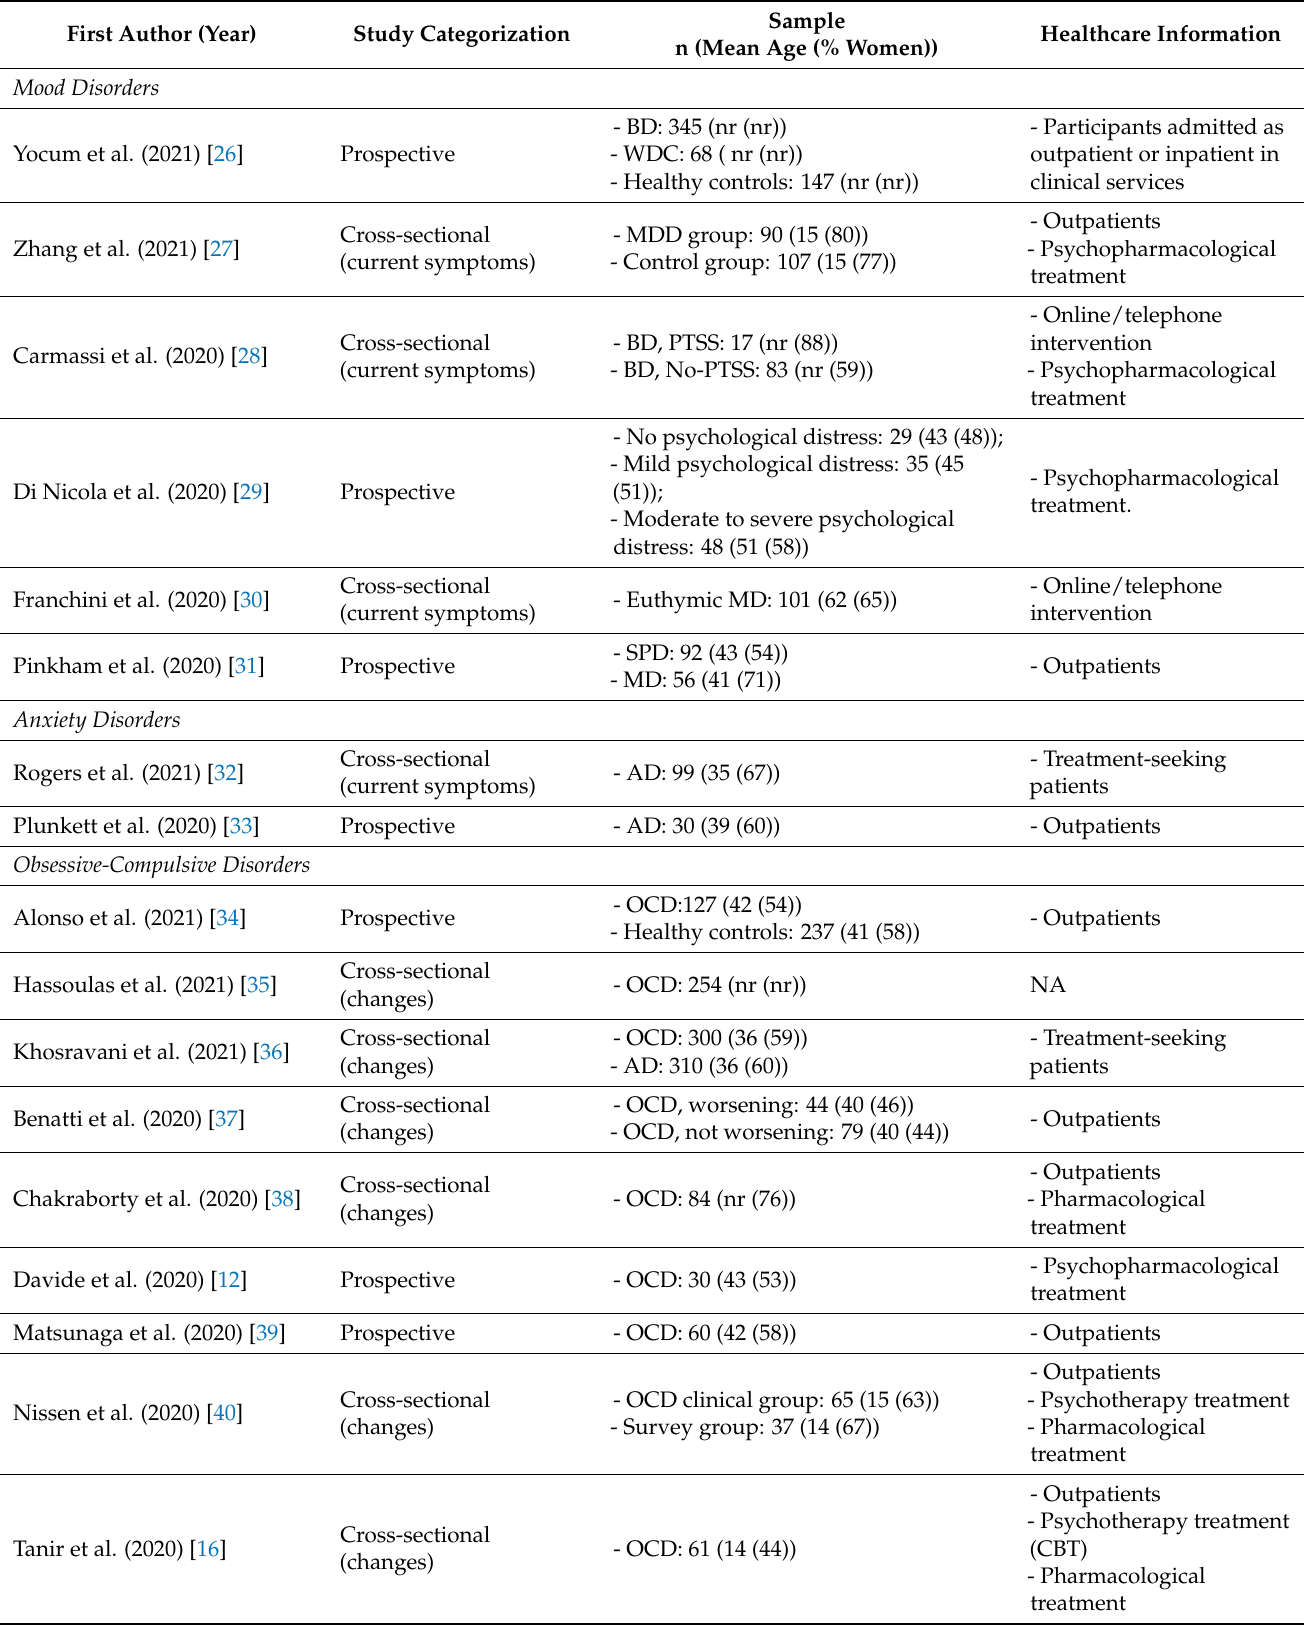
Table 1. Study design and sample